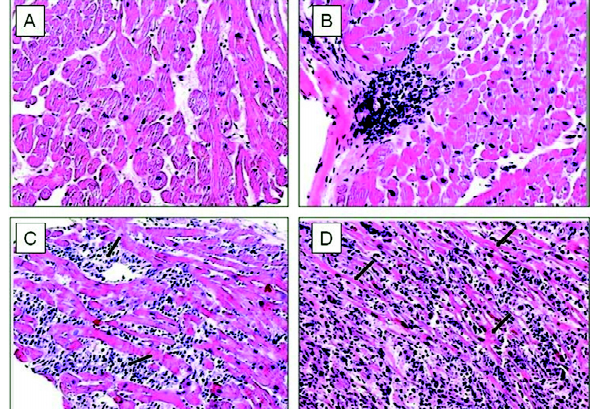
Fig. 3 - Microfotografias de biopsias endomiocárdicas (Hematoxilia-Eosina 100x), demonstrando no Painel A fibras miocárdicas em secção transversal (na região centro-esquerda) e longitudinal (na região direita) com arquitetura preservada e espaço intersticial sem sinais de infiltrado inflamatório. Ausência de rejeição (Grau 0R). Dimensão Fractal = 1,109; Painel B, na região central esquerda, foco único de infiltrado mononuclear agressivo, subendocárdico, com envolvimento de miócitos, destruição e apagamento da arquitetura regional. Rejeição celular aguda leve (Grau 1R). Dimensão Fractal = 1,370; Painel C com moderado infiltrado mononuclear e múltiplos focos de agressão aos miócitos (setas), ocasionando destruição e alargamento dos espaços intersticiais; Rejeição celular aguda moderada (Grau 2R). Dimensão Fractal = 1,460; Painel D com alteração da arquitetura por intenso infiltrado inflamatório mononuclear difuso, agressivo, com destruição maciça dos miócitos. Observar algumas fibras residuais em secção longitudinal (setas) permeadas pelo processo inflamatório; Rejeição celular aguda grave (Grau 3R). Dimensão Fractal =